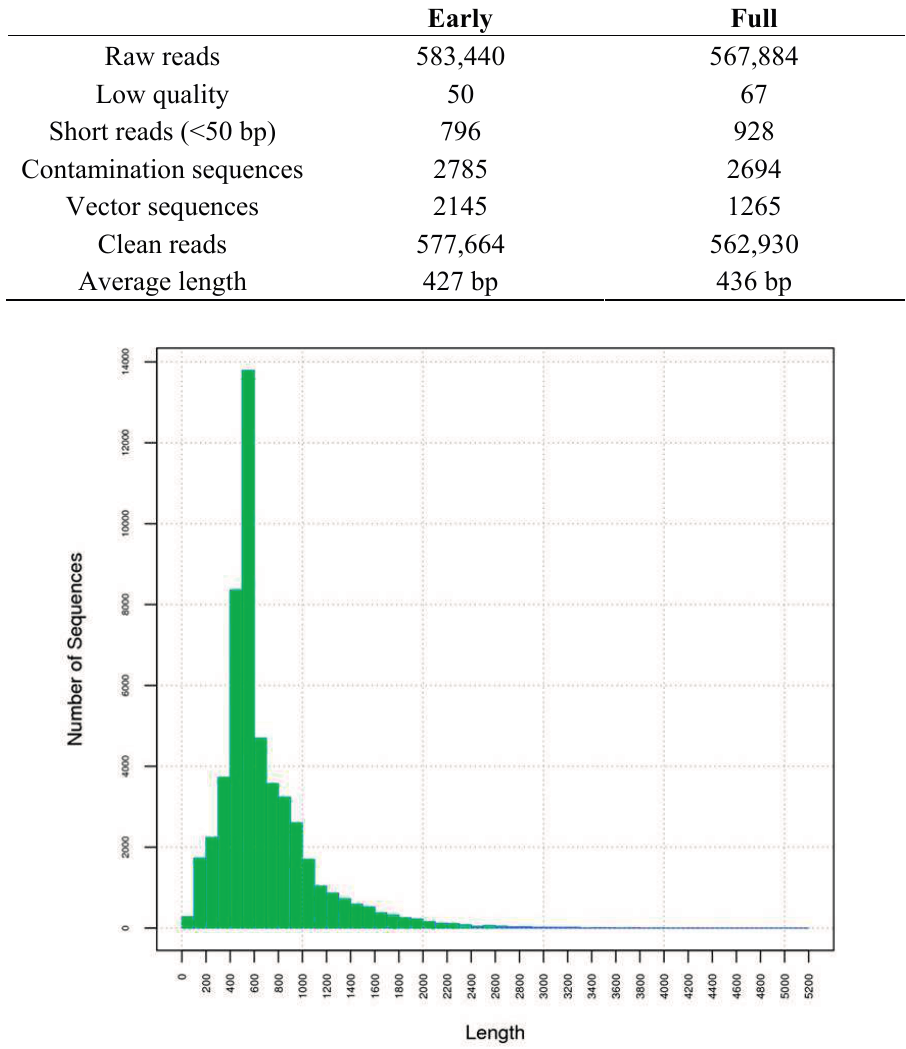
Figure 2. Length distribution of the safflower unigenes. The longest unigene was 5109 bp, and the average length of the unigenes was 679